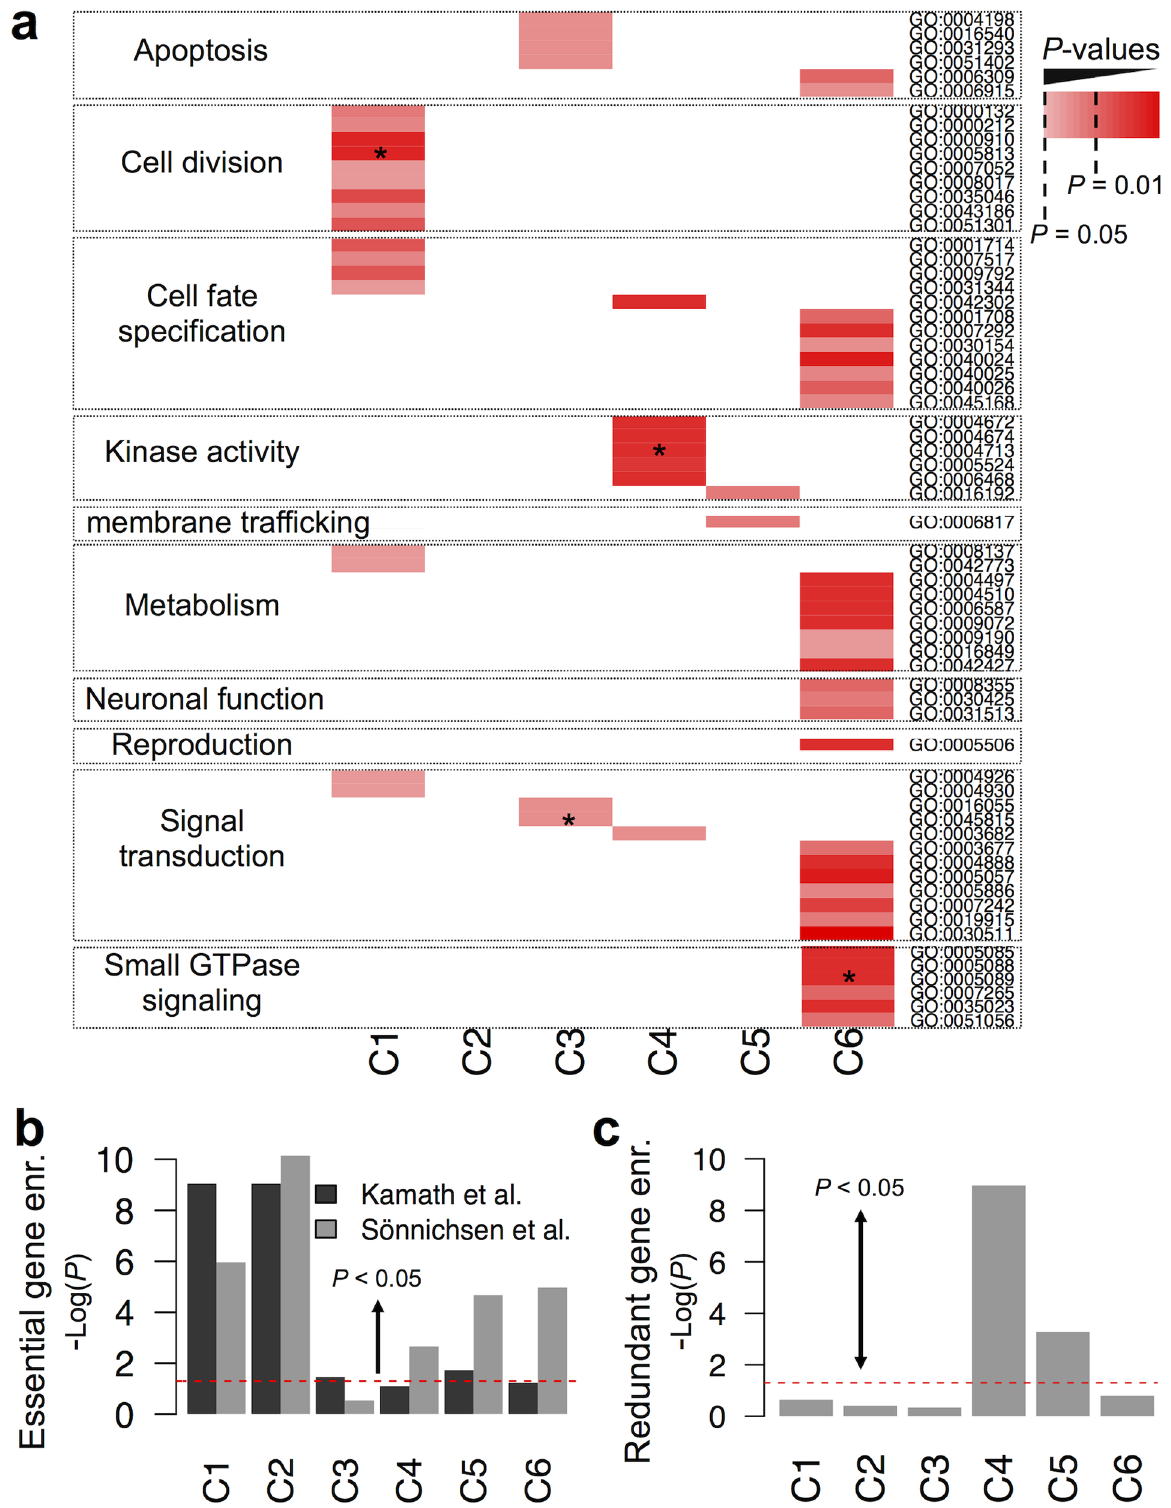
Fig 2. GI classes have different functions. (a) Summary of Gene Ontology (GO) term enrichments for interacting genes in individual genetic interactions (GIs) classes when compared to interacting genes from GIs-all. Only the statistically significant enrichments are shown with adjusted P -values. An asterisk ( * ) means that the GI class is also enriched with the functional annotation when gene repetitions were not considered (S2 Table). (b) Enrichments of